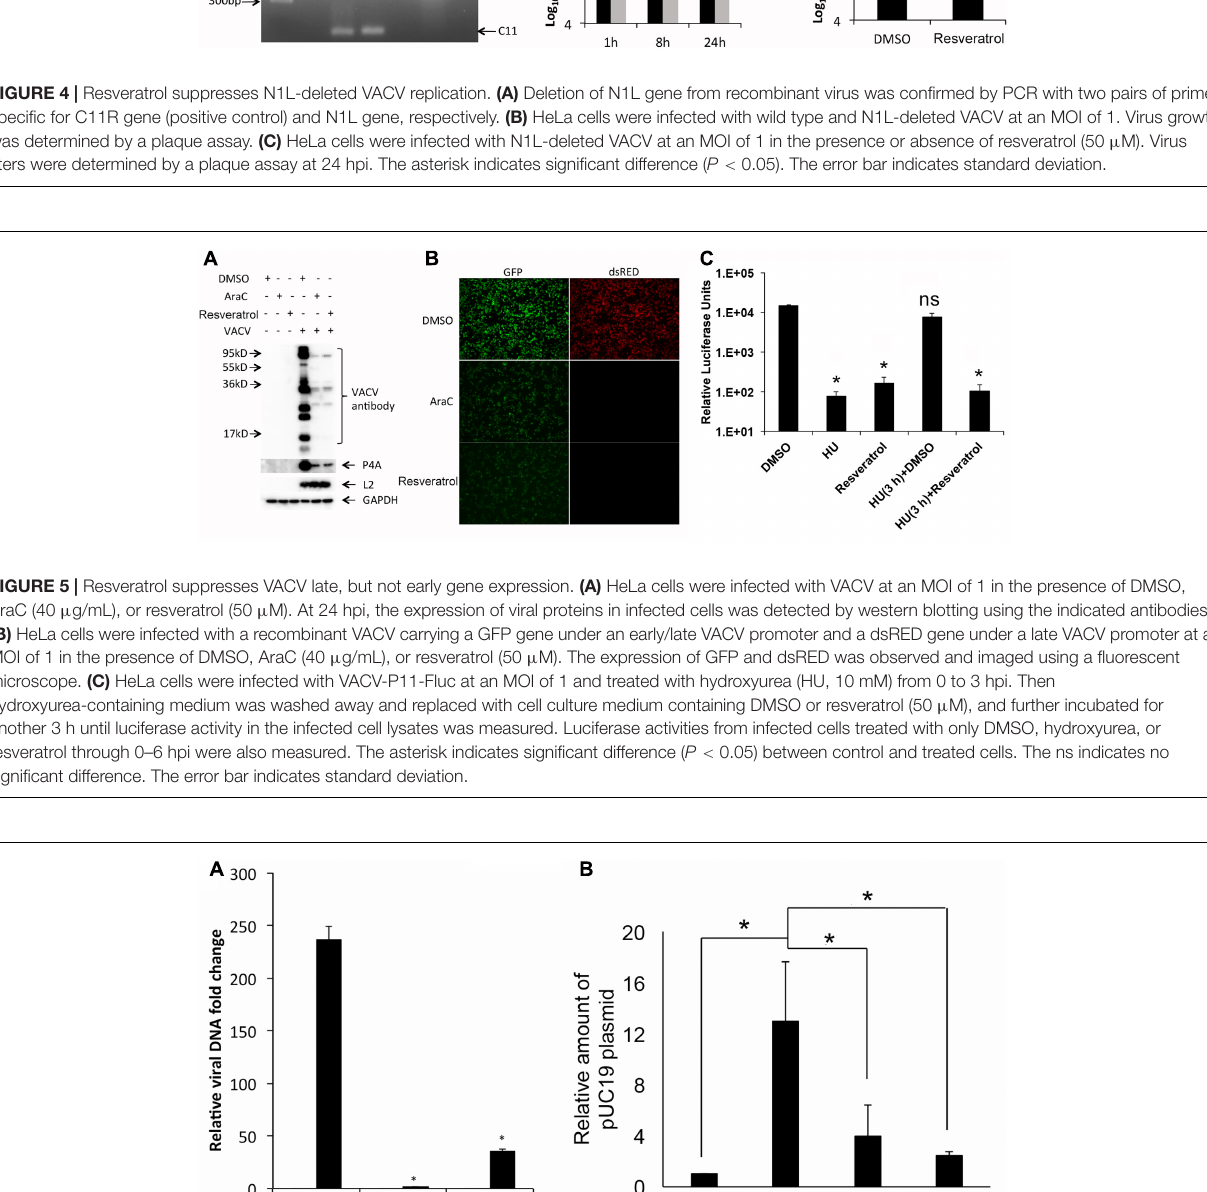
Frontiers in Microbiology |